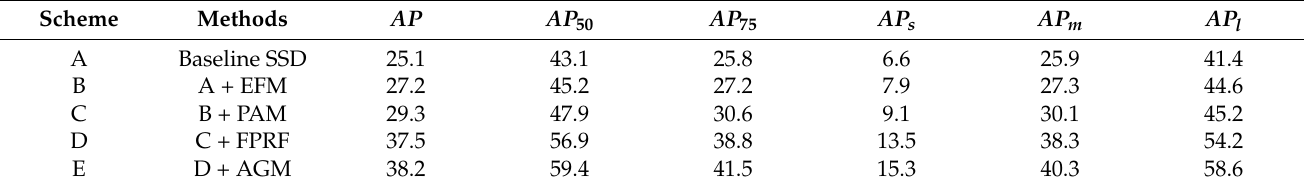
Table 5. Ablation studies of the FCSSD on the MS COCO minival with an image size of 300 ×